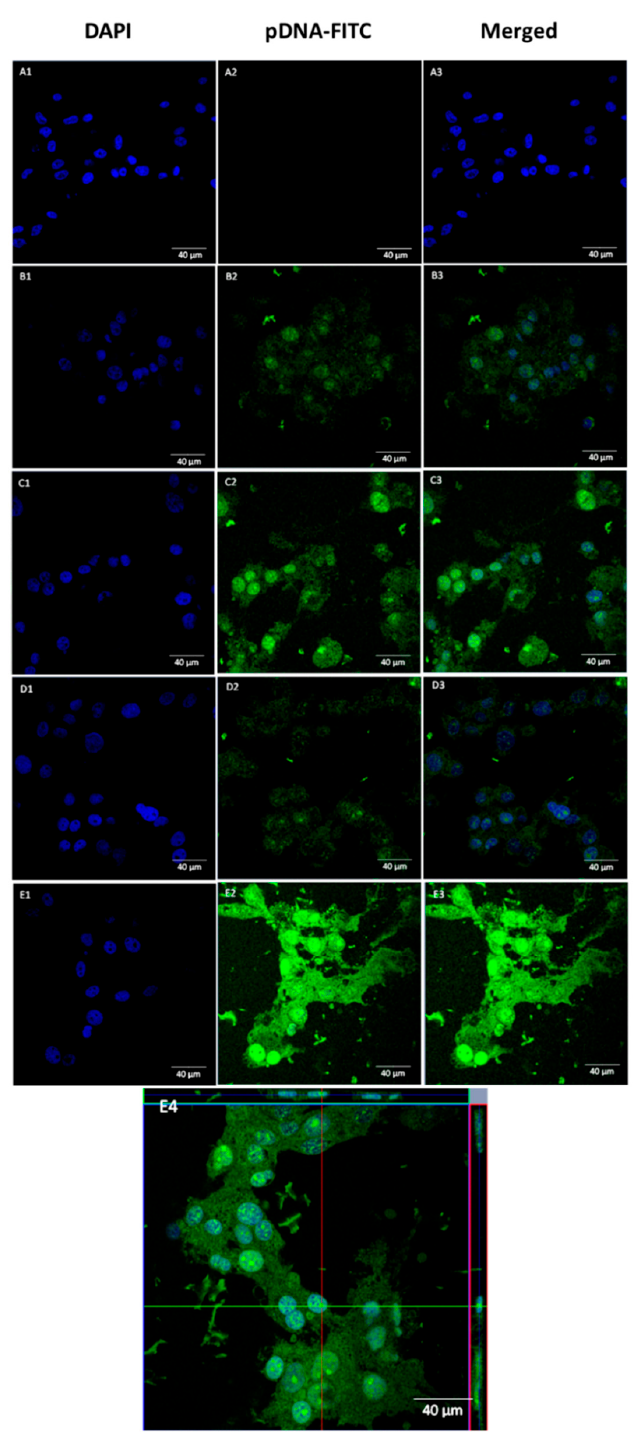
Figure 5. Fluorescence confocal microscopy evaluation of cellular uptake and intracellular co-localization displayed by the set of complexes, prepared at an N/P ratio of 1, after 4 h of transfection. Nuclei were stained blue by DAPI and green represents pDNA stained with FITC. The first panels show nuclei stained by DAPI, the second panels indicate labeled pDNA-FITC and the third panels correspond to merged images. Representative live-cell images of non-transfected U-87 cells ( A ), and U-87 cells transfected with the following complexes: WRAP5/pDNA ( B ), Tf-WRAP5/pDNA ( C ), TMZ/WRAP5/pDNA ( D ), TMZ/Tf-WRAP5/pDNA ( E ), and TMZ/Tf-WRAP5/pDNA, orthogonal view (E4). Scale bar = 40 µm.